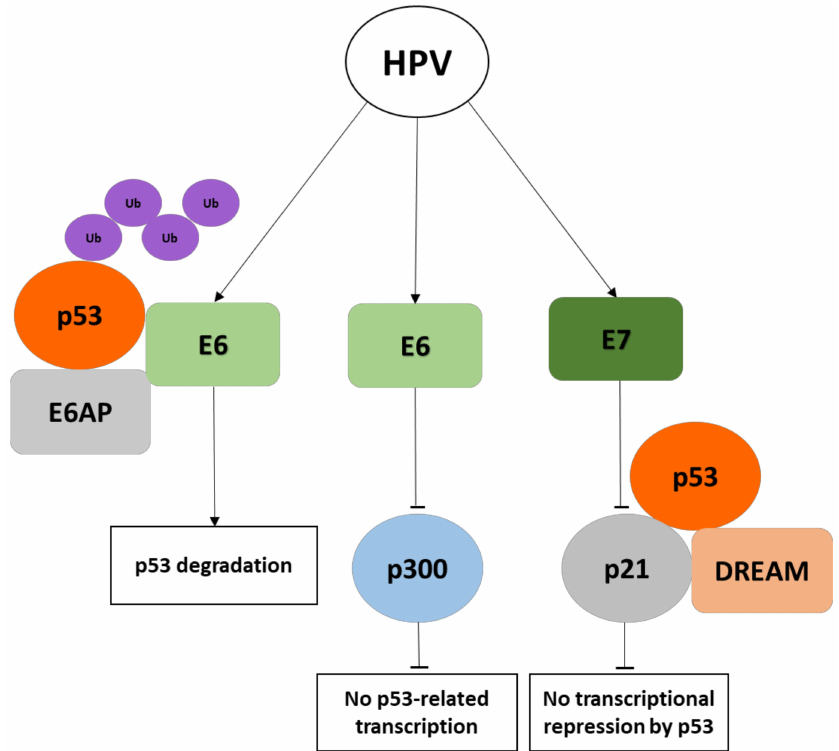
Figure 2. Schematic diagram of human papillomavirus (HPV) E6 and E7 oncoproteins affecting p53 activity. E6AP, E6-associated protein, Ub, ubiquitin, DREAM, DP–RB-like–E2F4–MuvB